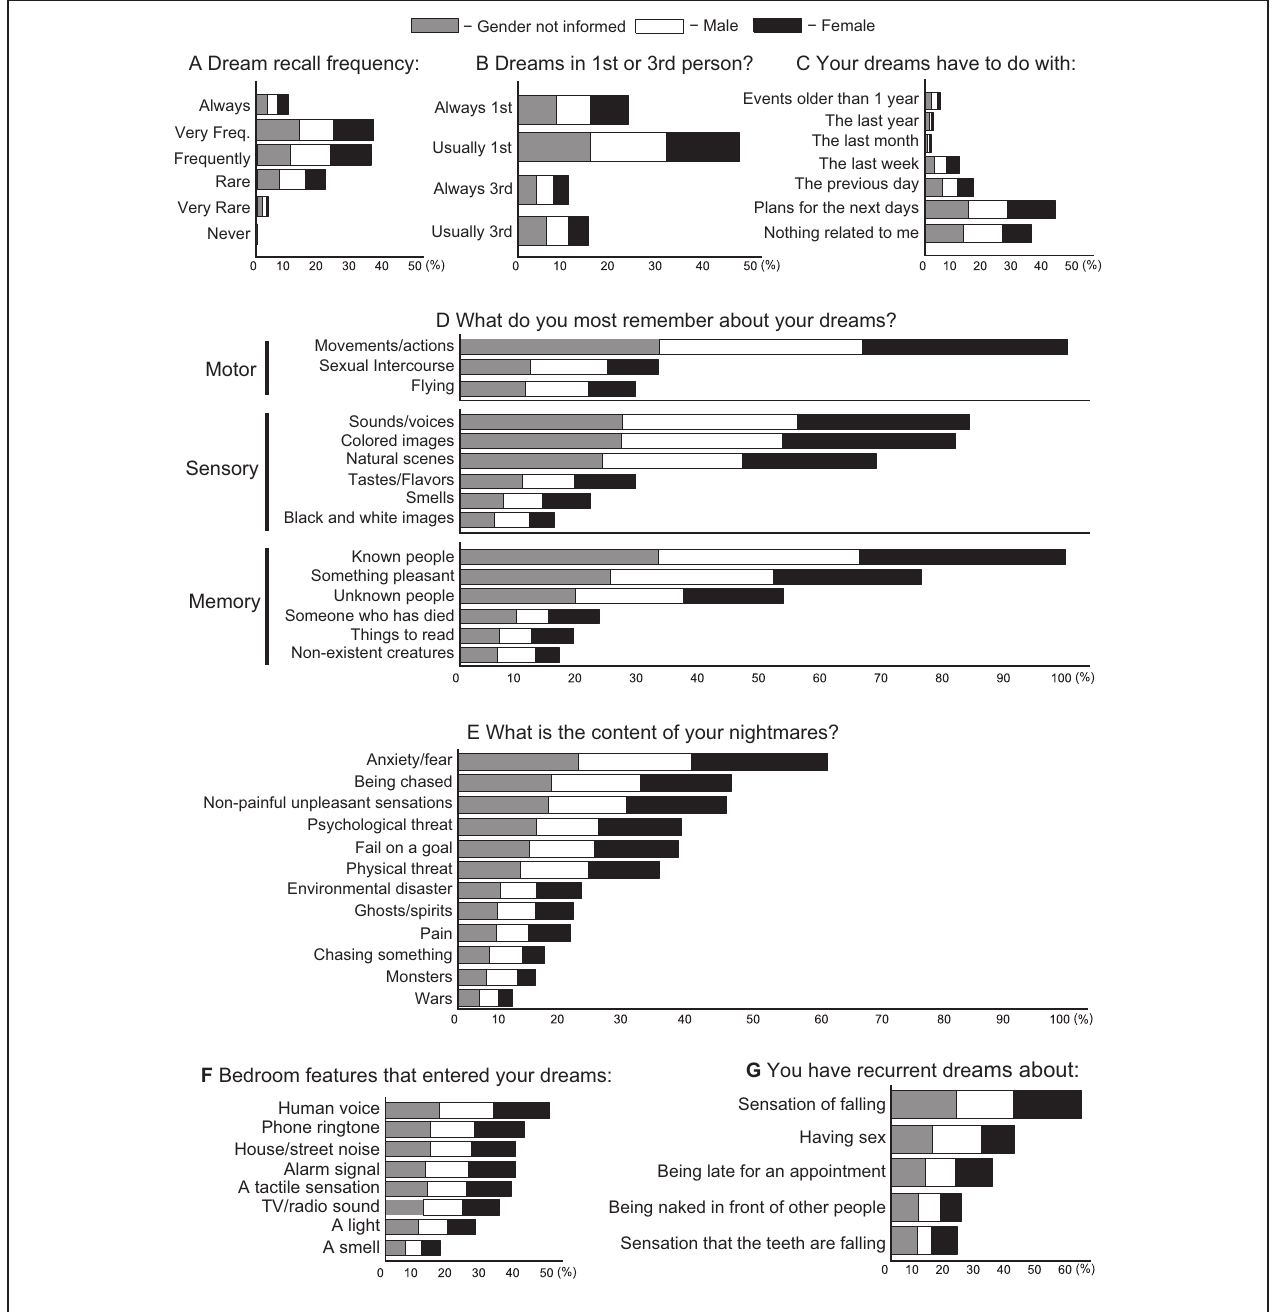
FIGURE 2 | Frequency and content of dreams and nightmares for female (black), male (white), gender not answered (gray). (A) Frequency of